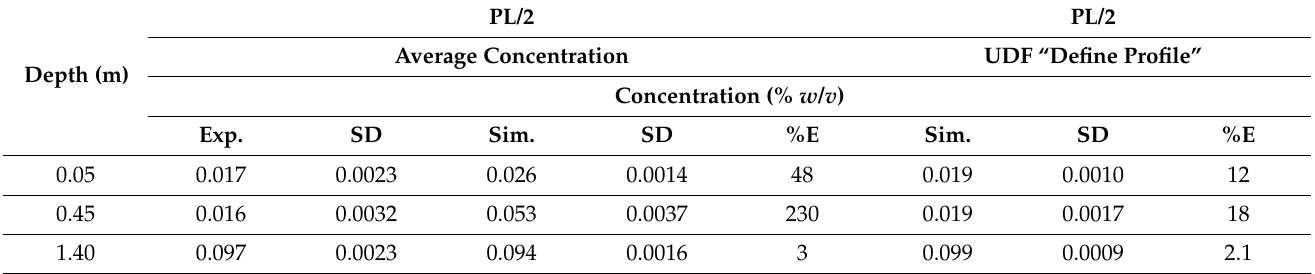
Table 4. Experimental and simulated solids profile inside the facultative lagoon .